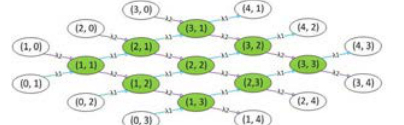
Figure 4 (e) Case 4: System state transformed from idle mode to busy mode Formulas 7 to 18 are balance equation for the busy state. Its range involves the transition from